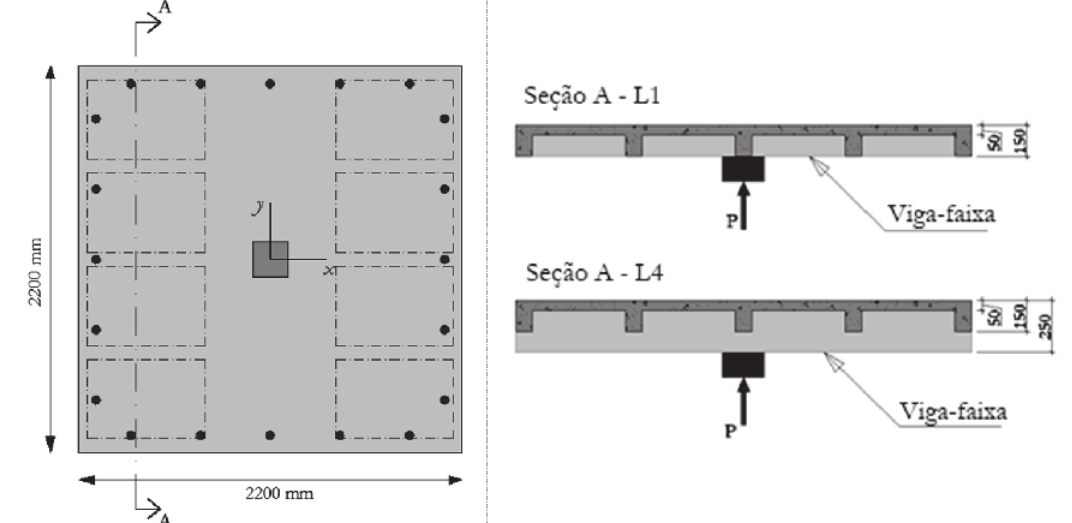
Dimensões das lajes da série em